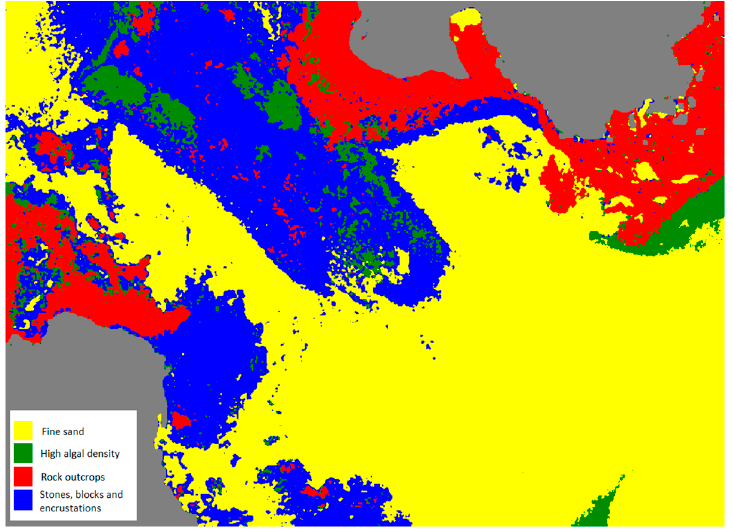
Figure 12. Result of the benthic high-resolution classification map using SVM and endmember abundances and bathymetry generated in the Marine Optical Model.